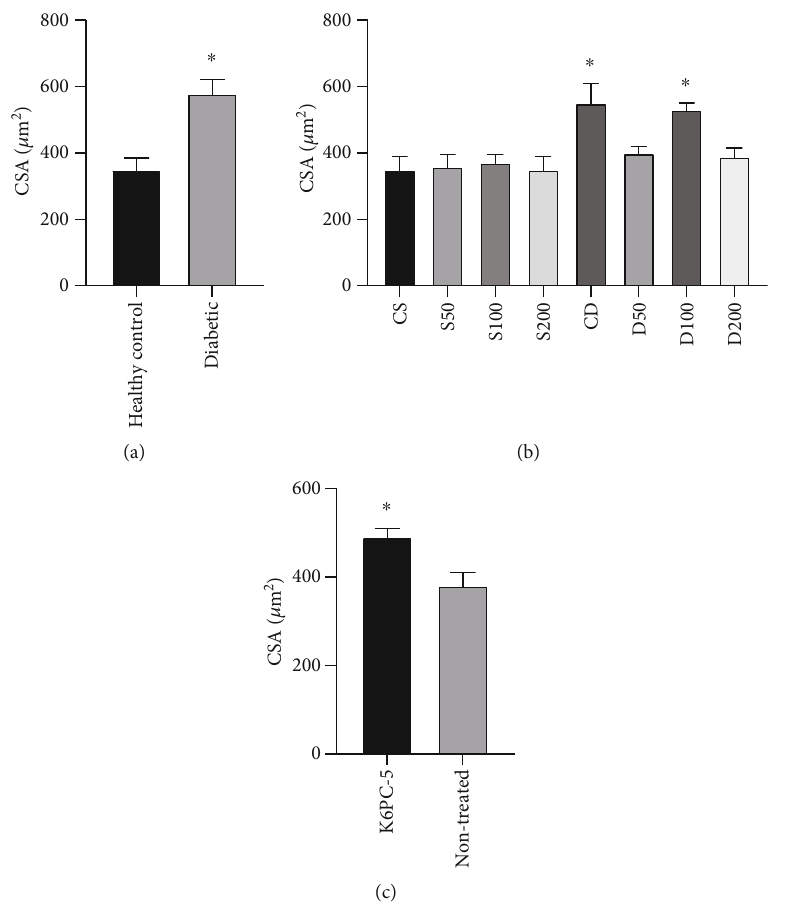
Figure 1: (a) Comparison of average of CSA between diabetic and healthy nontreated rats ( ∗ p < 0 : 05 ). (b) Comparison of myocytes ’ cross- sectional area ( ∗ p < 0 : 005 ). (c) Comparison of myocytes ’ cross-sectional area between K6PC-5 treated and nontreated rats ( ∗ p < 0 : 05